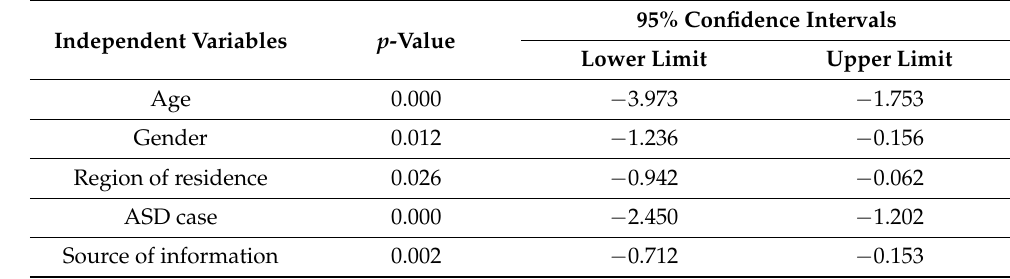
Table 7. Multiple linear regression with ASD knowledge as the dependent